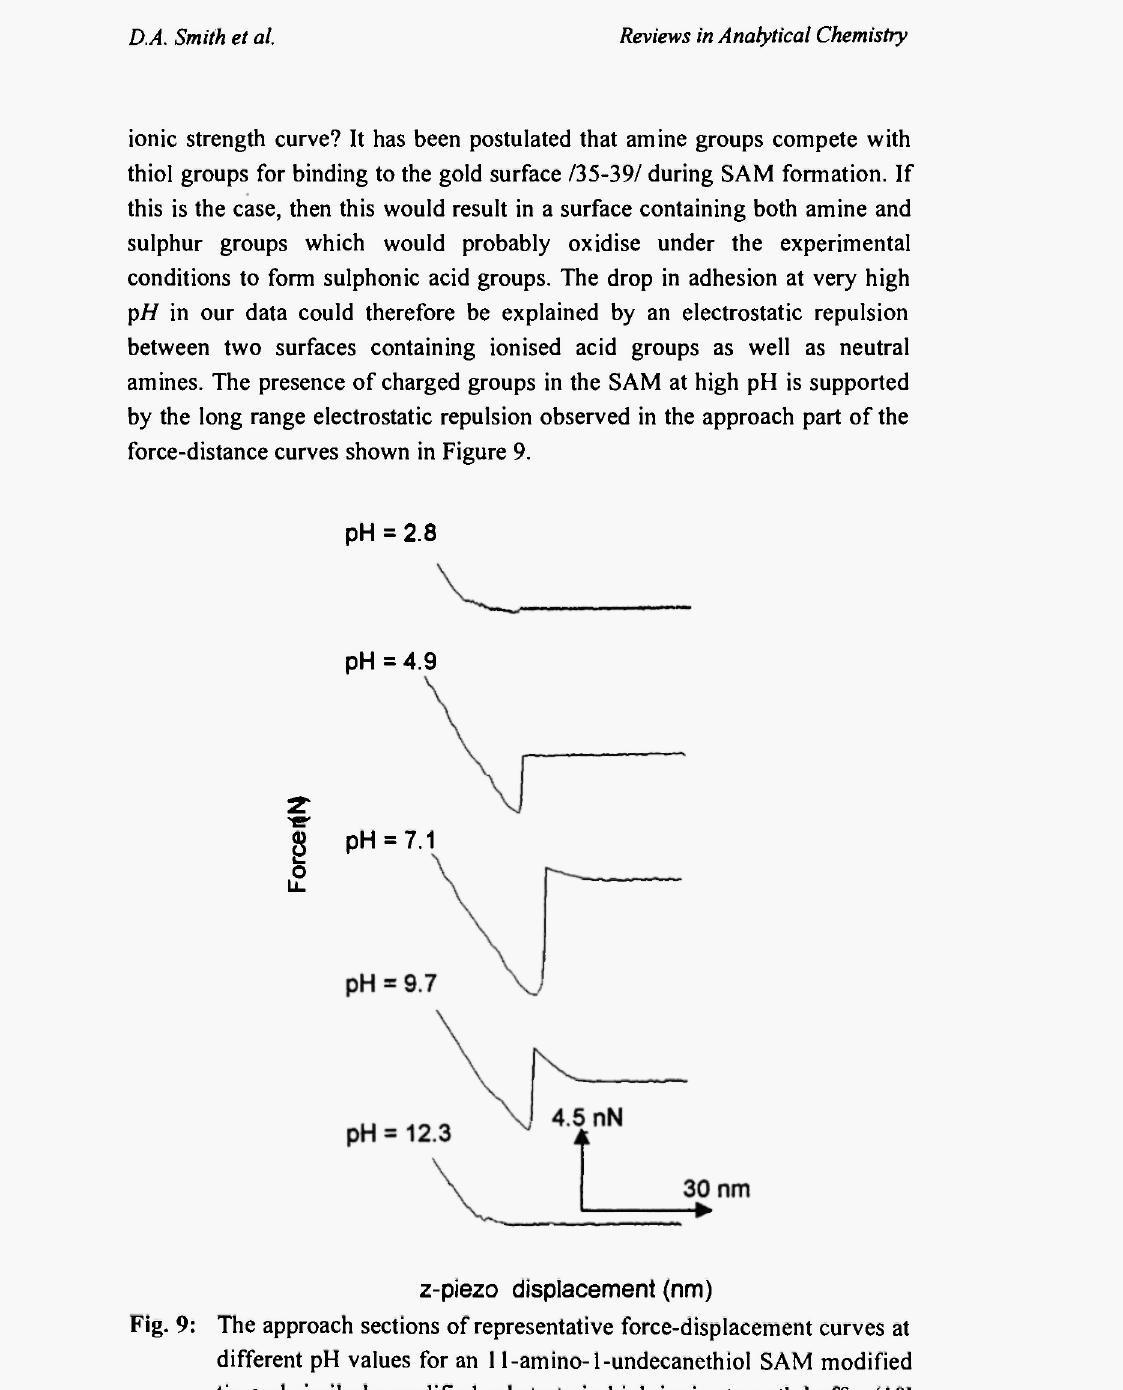
Fig. 9: The approach sections of representative force-displacement curves at different pH values for an 11-amino-l-undecanethiol SAM modified tip and similarly modified substrate in high ionic strength buffer (10" 1